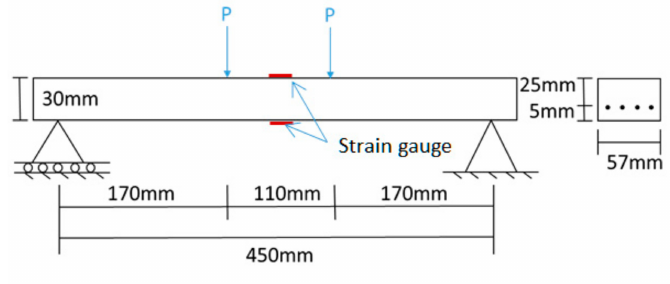
Figure 9. Schematic of the concrete beam